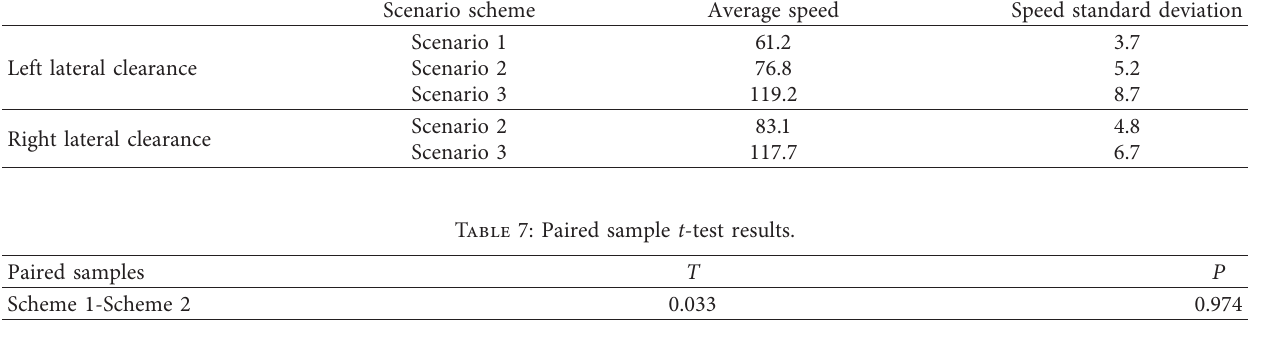
Table 8: Analysis of variance afterwards multiple comparison results.